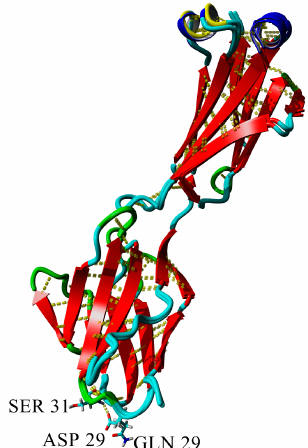
Figure 11. Superposition of wild-type and D29Q variants of BIF. Difference between wild-type of BIF and D29Q mutant: wild-type forms a hydrogen bond with S31, whereas in the mutant the hydrogen bond is lost.